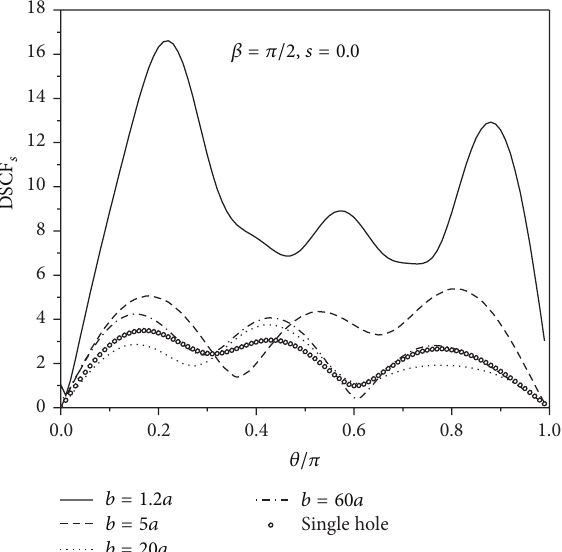
Figure 9: Distribution of DSCF along the middle hole for different separation of 𝑏 for 𝛽 = 0.001 and 𝑠 = 0 .